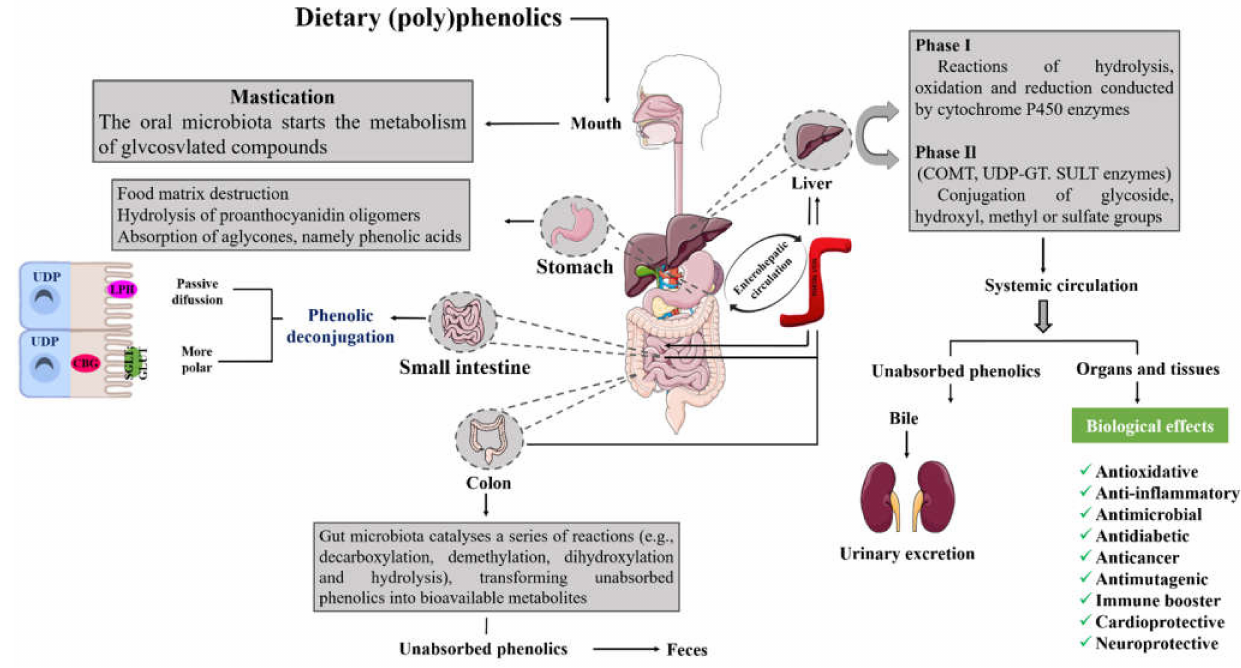
Figure 5. Schematic representation concerning phenolics’ absorption, metabolism, distribution, and excretion (COMT, catechol O-metiltransferase; UDP, uridine 5 (cid:48) -diphospho-glucuronosyltransferase; UDP-GT, glucuronil-transferase; SULT, sulfotransferase; LPH, lactase-phlorizin hydrolase; SGLT, sodium-dependent glucose cotransporters, GLUT, glucose transporters; CBG, cytosolic β -glucosidase). Figure created with Smart Servier Medical Art tools (https://smart.servier.com, 1 January